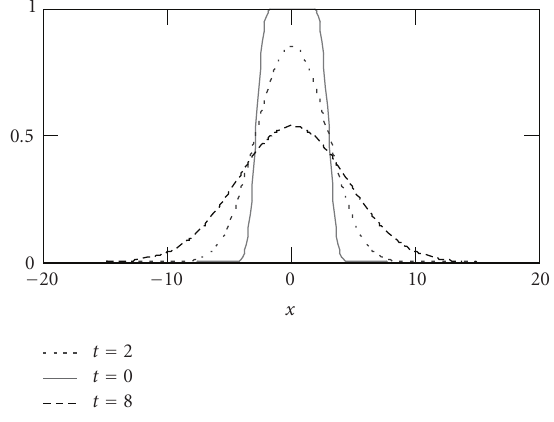
Figure 3.3. FBF evolution m = 8 at di ff erent times (continuous: t = 0; dotted: t = 2; dashed: t =